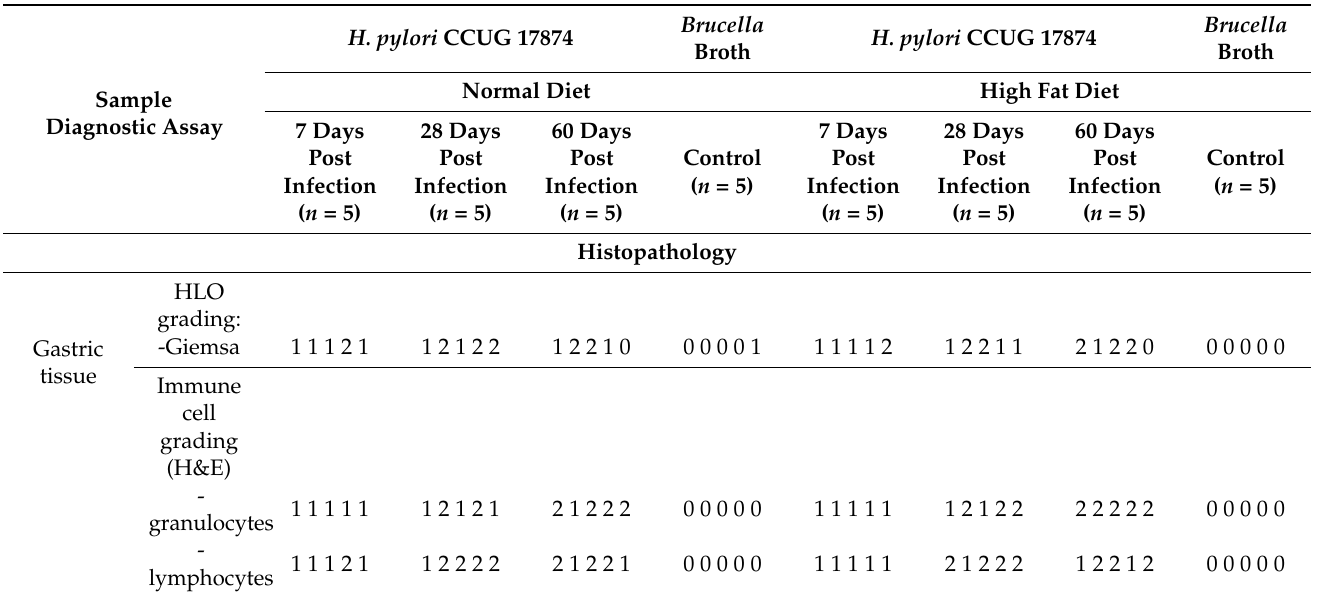
Table 1. Validation of H. pylori infection by grading Helicobacter -like organisms (HLO) and gastritis in the stomach of guinea pigs inoculated with the reference H. pylori strains at 7, 28 and 60 days of infection. The visual grading system for HLO is 0—no bacteria detected in gastric crypts; 1—mild level of colonization (some bacteria detected in gastric crypts); 2—moderate level of colonization (bacteria detected in most gastric crypts); and 3—severe level of colonization (bacteria present in all gastric crypts). For cell infiltration it is 0—no infiltration of inflammatory cells; 1—moderate infiltration of inflammatory cells; and 2—increased infiltration of